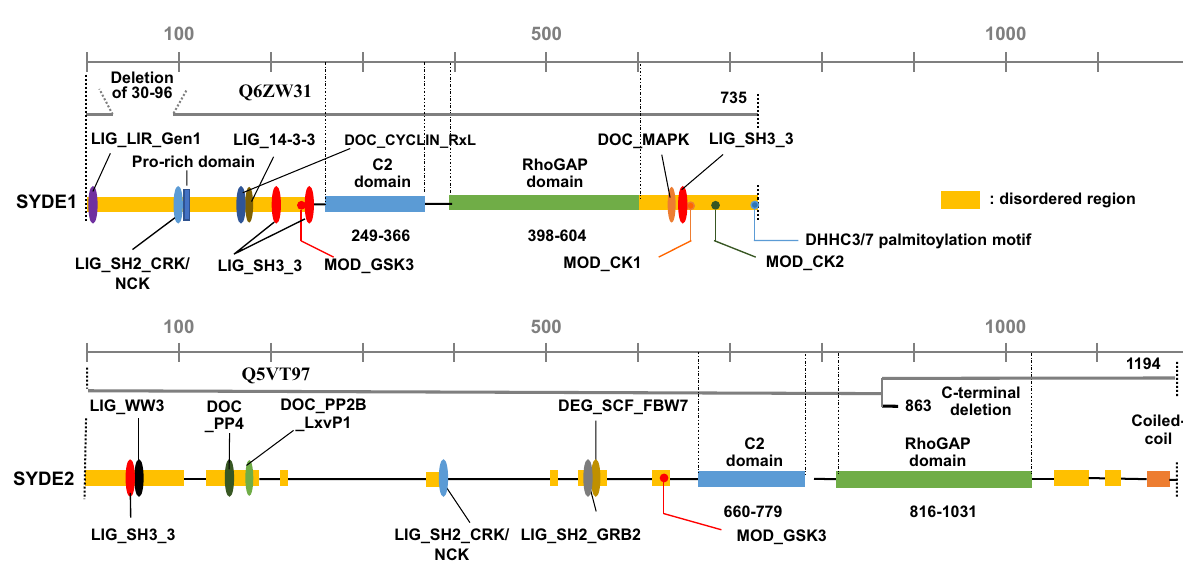
Figure 2. Domain architecture of SYDE proteins based on their sequence analysis. Both human SYDE proteins are characterized by disorder domain (yellow), C2 (light blue) and RhoGAP domain (green) that are indicated as sequence boundaries of human SYDEs (SYDE1: Q6ZW31; SYDE2: Q5VT97). Conserved linear motifs among vertebrates and mammals for SYDE1 and SYDE2, respectively, are represented as the following according to Dinkel et al . (2016): Canonical LIR motif required for ATG8-mediated autophagy (LIG_LIR_Gen1) (purple oval); Crk and Nck SH2 domain binding motif (LIG_SH2_CRK/NCK) (light blue oval); 14-3-3 interaction motif (LIG_14-3-3) (brown oval); Cyclin/CDK binding motif (DOC_Cyclin_RxL) (dark blue oval); PPR-specific WW domain (LIG_WW3) (black oval); a docking motif mediating interaction with Erk1/2 and p38 subfamilies of MAP kinases (DOC_MAPK) (orange oval); calcineurin docking motif (DOC_PP2B_LxvP1) (light green oval); FxxP-like docking motif recognized by PP4 holoenzyme (DOC_PP4) (dark green); Phsopho-dependent degron recognized by FBW7 Fbox proteins (DEG_SCF_FBW7) (dark yellow oval); Casein kinase (CK1) phosphorylation site (MOD_CK1) (orange dot); CK2 phosphorylation site (MOD_CK2) (dark green dot); DHHC3/7 palmitoylation site (green dot); GSK3 phosphorylation site (MOD_GSK3) (red dot); SH3 binding site (LIG_SH3_3) (red oval); Grb2-like SH2 domains binding motif (LIG_SH2_GRB2) (gray oval). Alternative SYDE isoforms are indicated and the SYDE1 isoform Q6ZW31-2 (668 residues) is missing the N-terminal region (30–96). SYDE2 isoform Q5VT97-2 (863 residues) is truncated at residue 849 with substitution in the region from position 850 to 863